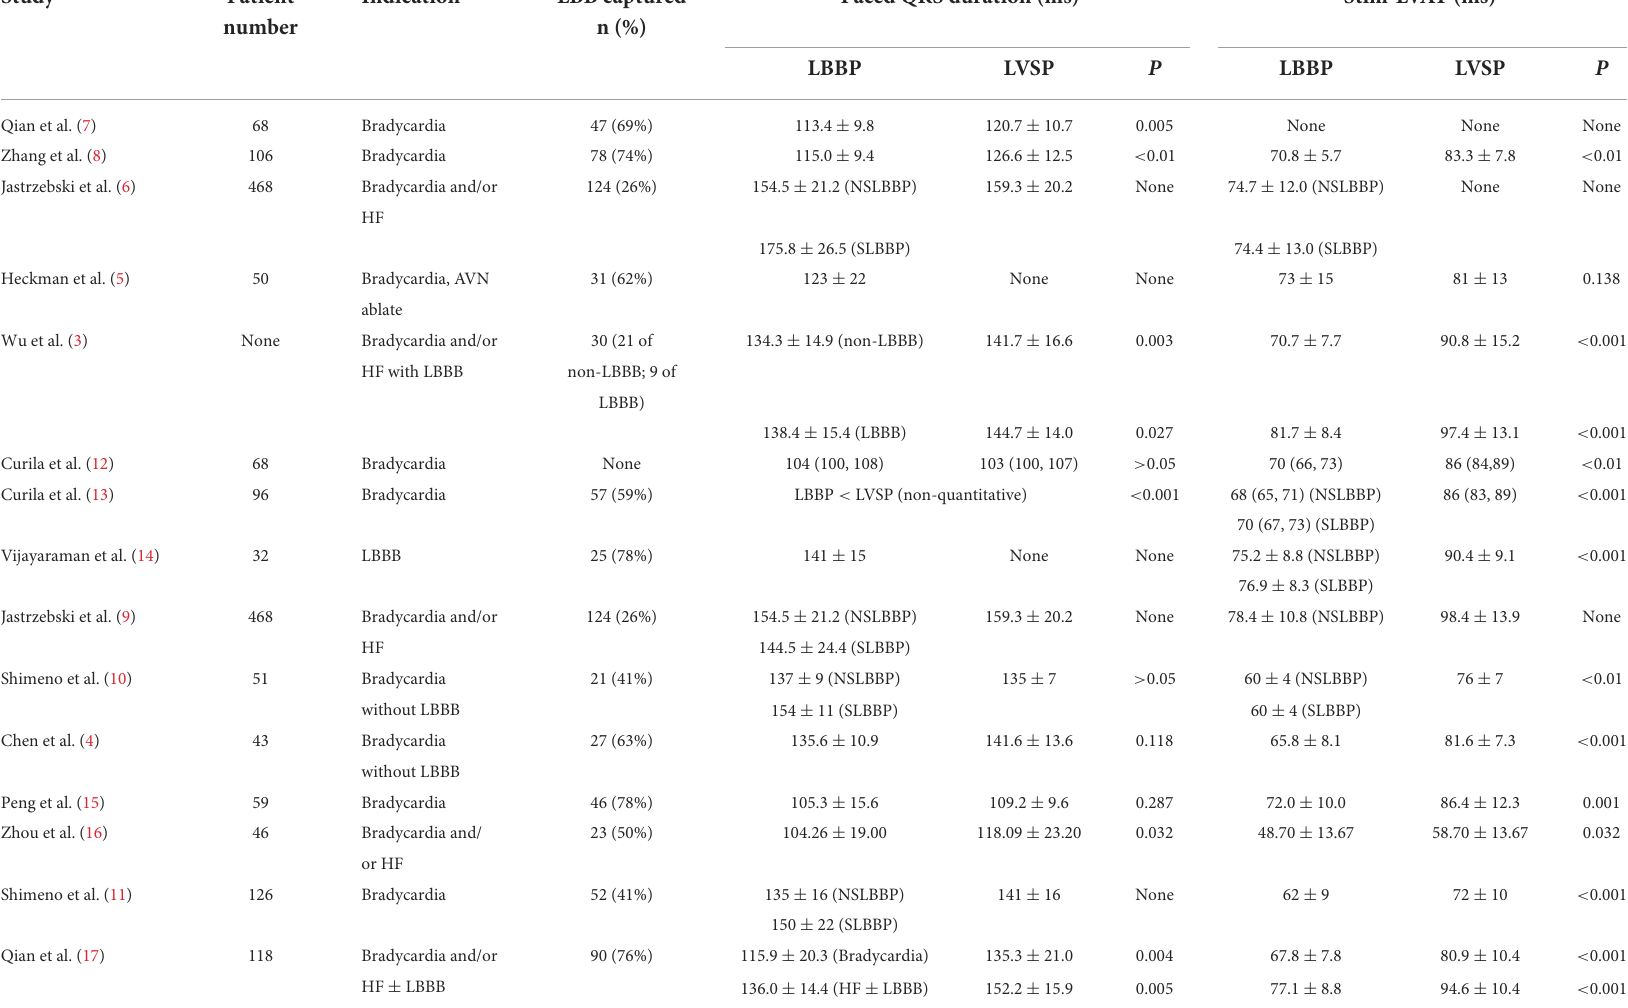
TABLE 1 Study characteristics of included